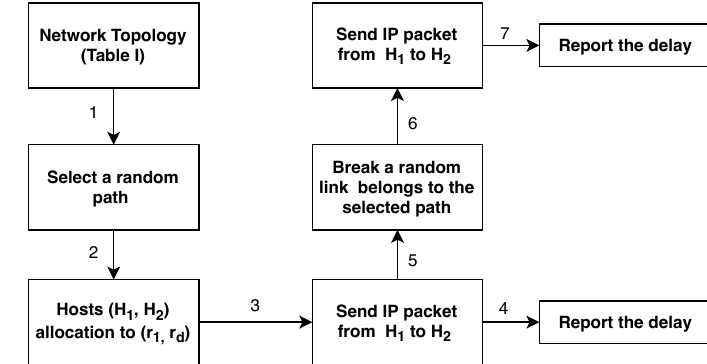
Figure 9. Process of measuring the cost of path installation.